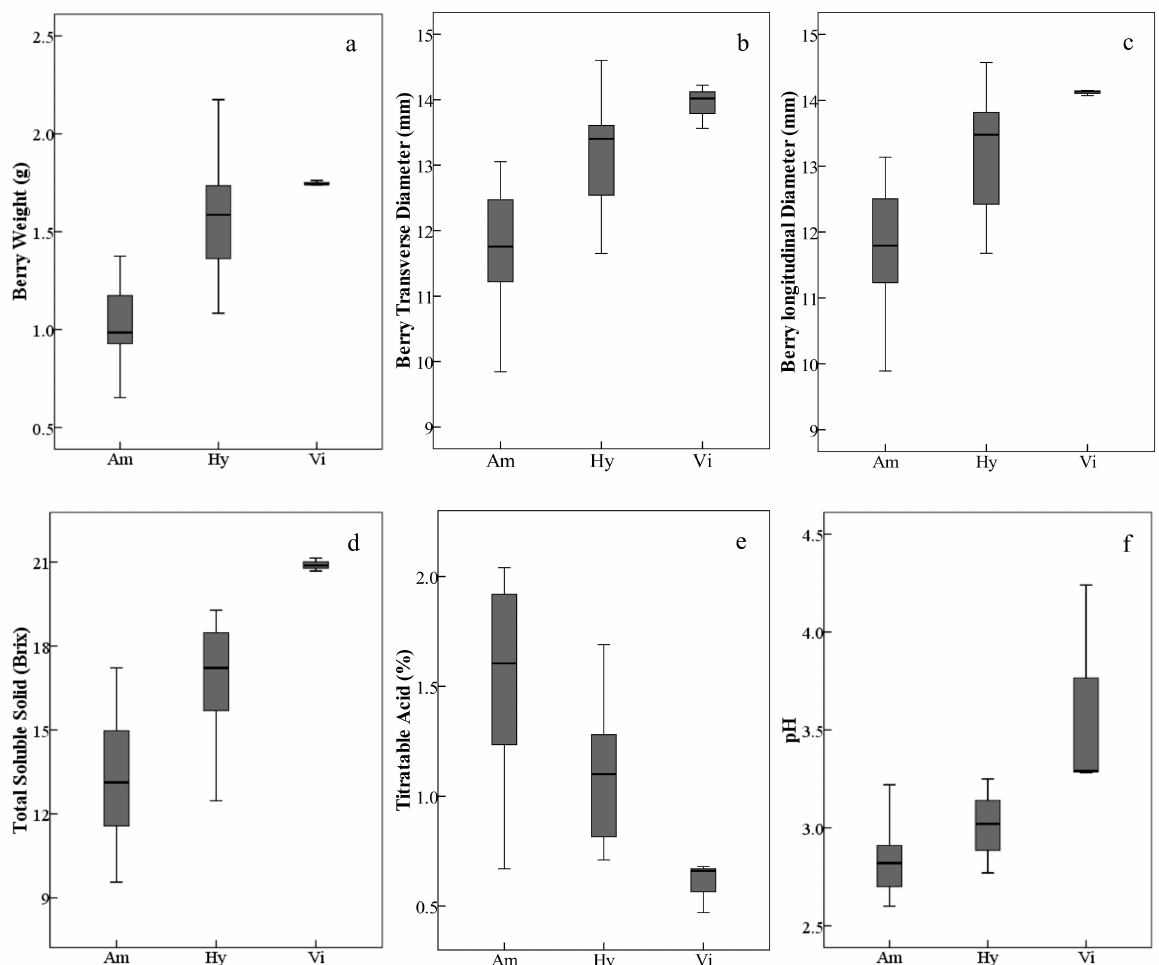
Figure 1. Ranges and distributions of weight ( a ), transverse diameter ( b ), longitudinal diameter ( c ), total soluble solid ( d ), titratable acid ( e ) and pH ( f ) of ripe berries belonging to different grape species/groups harvested in 2017 and 2018. The height of each box is equal to the interquartile range. The horizontal line in the interior of each box is the median. The whiskers extended from the top and bottom of each box with horizontal lines are the maximums and minimums, respectively. Abbreviations: Am, V. amurensis ; Hy, hybrids of V. amurensis and V. vinifera ; Vi, V. vinifera